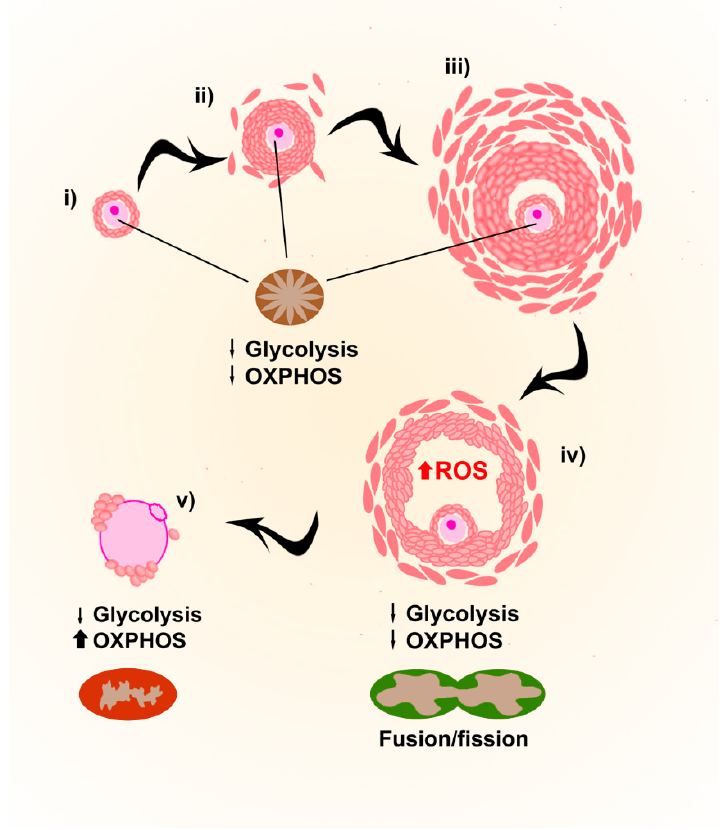
Figure 4. Mitochondrial requirements during oogenesis. After birth and up to puberty, primary follicles ( i ) and immature oocytes are stored in a quiescent state characterized by immature mitochondria. After puberty, folliculogenesis starts producing secondary follicles ( ii ), antral follicles ( iii ) and preovulatory follicles ( iv ). The low energetic requirements of growing oocytes are provided by cumulus cells (theca and granulosa cells), providing ATP and pyruvate by metabolizing glucose via glycolysis. In preovulatory follicles, granulosa cells increase ROS levels to favor apoptosis of cumulus cells to induce ovulation. During final meiotic maturation, just before ovulation ( v ), functional mitochondria are located in a layer in the subcortical region.